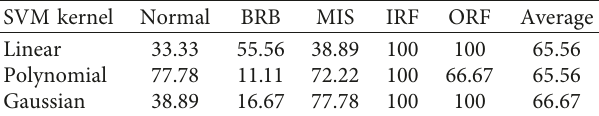
Table 6: Classification accuracy of the vibration signal by different SVM kernels (%).